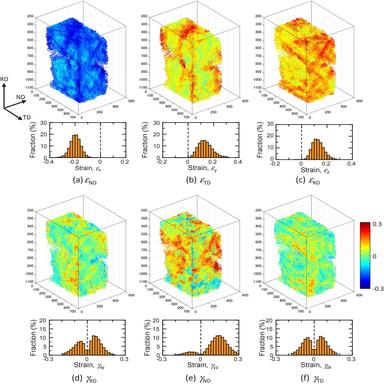
Strain distribution obtained by the microstructural feature tracking method for 20.2% cold rolling experiment in a pure aluminium.